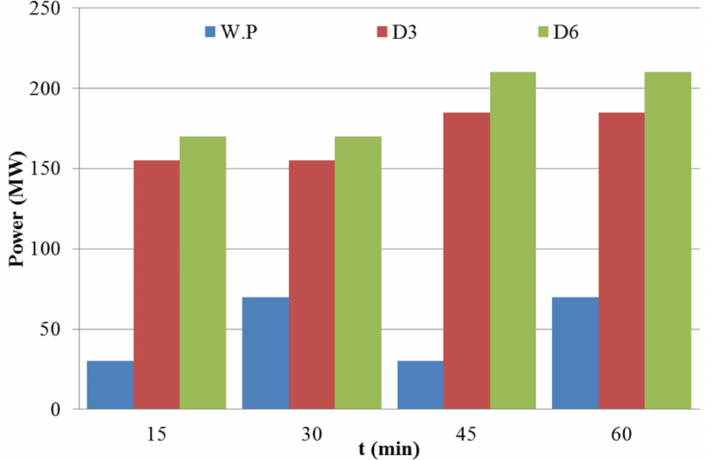
Figure 3. Variations of wind power and demand.